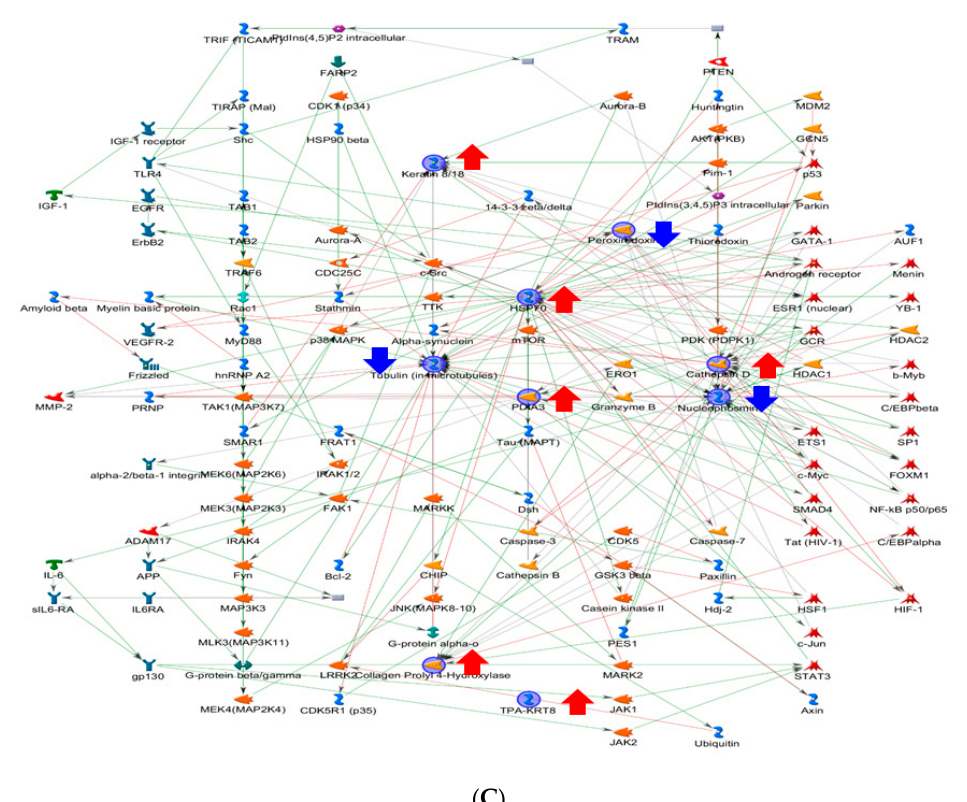
Figure 2. ( A ) Silver-stained 2-DE patterns of MCF-7 and ZR-75-1 cells. The protein lysate (180 μ g) was focused on a pH 4–7 linear IPG strip before being separated on 10% polyacrylamide gels and the protein spots with significantly increasing intensity were labeled as Arabic numerals. ( B ) Validation of the difference in protein expression revealed by 2-DE experiment between MCF-7 and ZR-75-1 cells. Protein levels of PDIA3, cathepsin D, Nucleophosmin and PRX2 were assessed by a Western blot analysis. The quantified results were calculated and indicated by the bar chart. GAPDH was used as a loading control (*** p < 0.001). ( C ) Biological network analyses of differentially expressed proteins using MetaCore TM mapping tools. Nodes represent proteins and lines between the nodes indicate direct protein–protein interactions. The red up arrows demonstrate the increased proteins and the blue down arrows indicate the decreased proteins. The various proteins on this map are indicated by different symbols representing the functional class of the proteins.